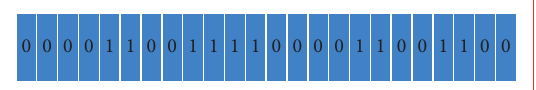
Figure 16: Optimal locations of roadside units.